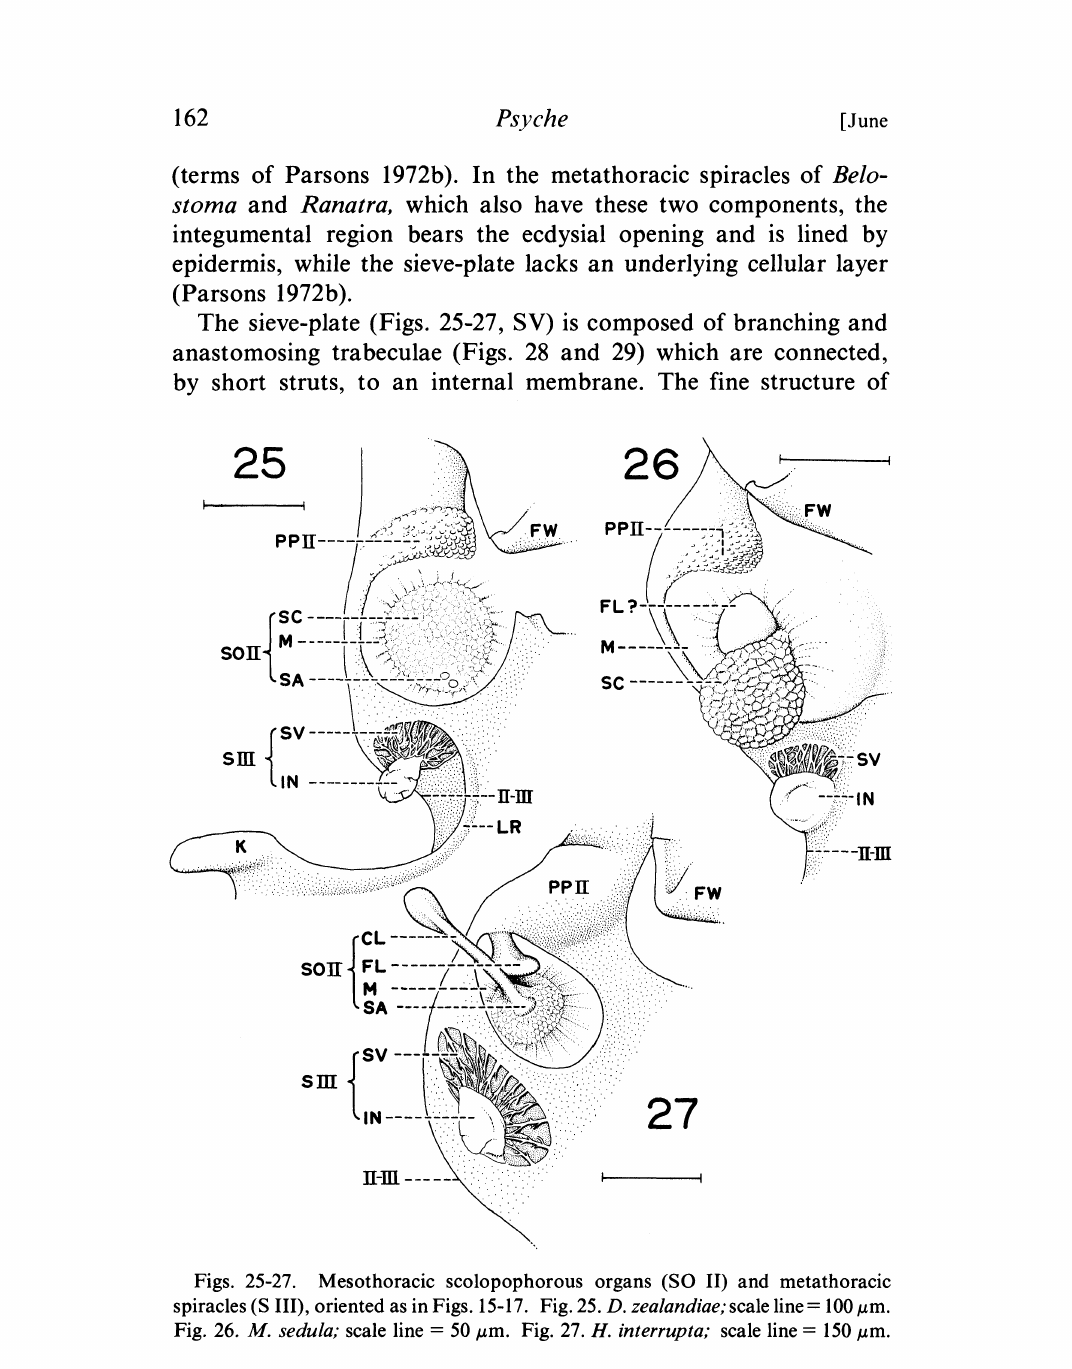
Figs. 25-27. Mesothoracic scolopophorous organs (SO II) and metathoracic spiracles (S III), oriented as in Figs. 15-17. Fig. 25. D. zealandiae;scale line= 100 #m. Fig. 26. M. sedula; scale line 50 #m. Fig. 27. H. interrupta; scale line 150